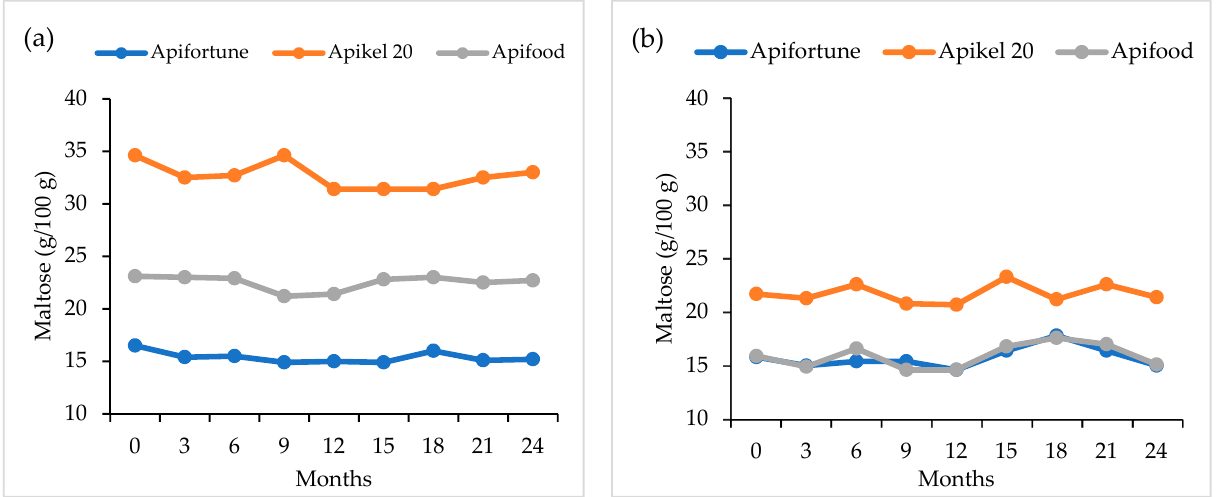
Agriculture 2021 , 11 , x FOR PEER REVIEW Figure 13. Changes of maltose content in syrups during storage at about 4 °C ( a ) from 2012 and ( b ) from 2013. Figure 13. Changes of maltose content in syrups during storage at about 4 °C ( a ) from 2012 and ( b ) from 2013. Figure 13. Changes of maltose content in syrups during storage at about 4 ◦ C ( a ) from 2012 and ( b ) from 2013.